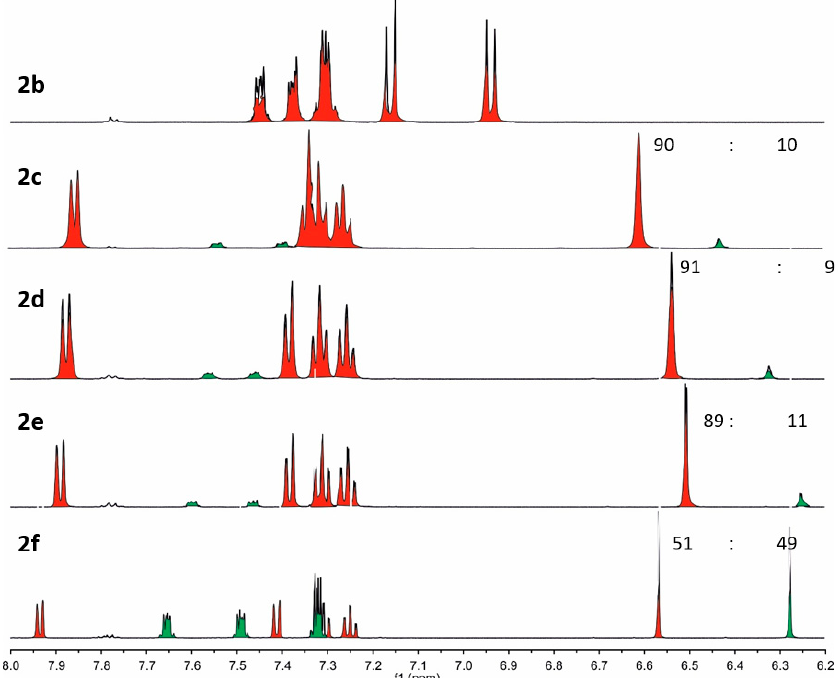
Figure 1. 1 H-NMR spectra (500 MHz, 6–8 ppm) of the crude photooxygenation products of carbohydrate-substituted naph- 1 H-NMR spectra (500 MHz, 6–8 ppm) of the crude photooxygenation products of thalenes 2b – f (major isomer red, minor isomer green). Figure 1. carbohydrate-substituted naphthalenes 2b – f (major isomer red, minor isomer